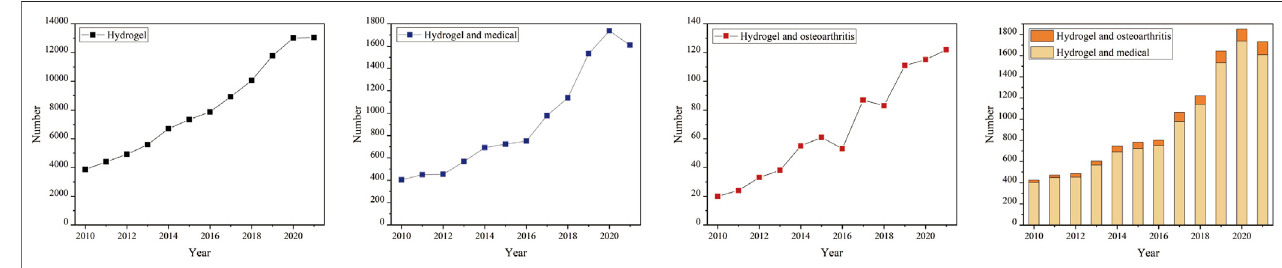
FIGURE 1 | 2010 – 2021 hydrogel-related